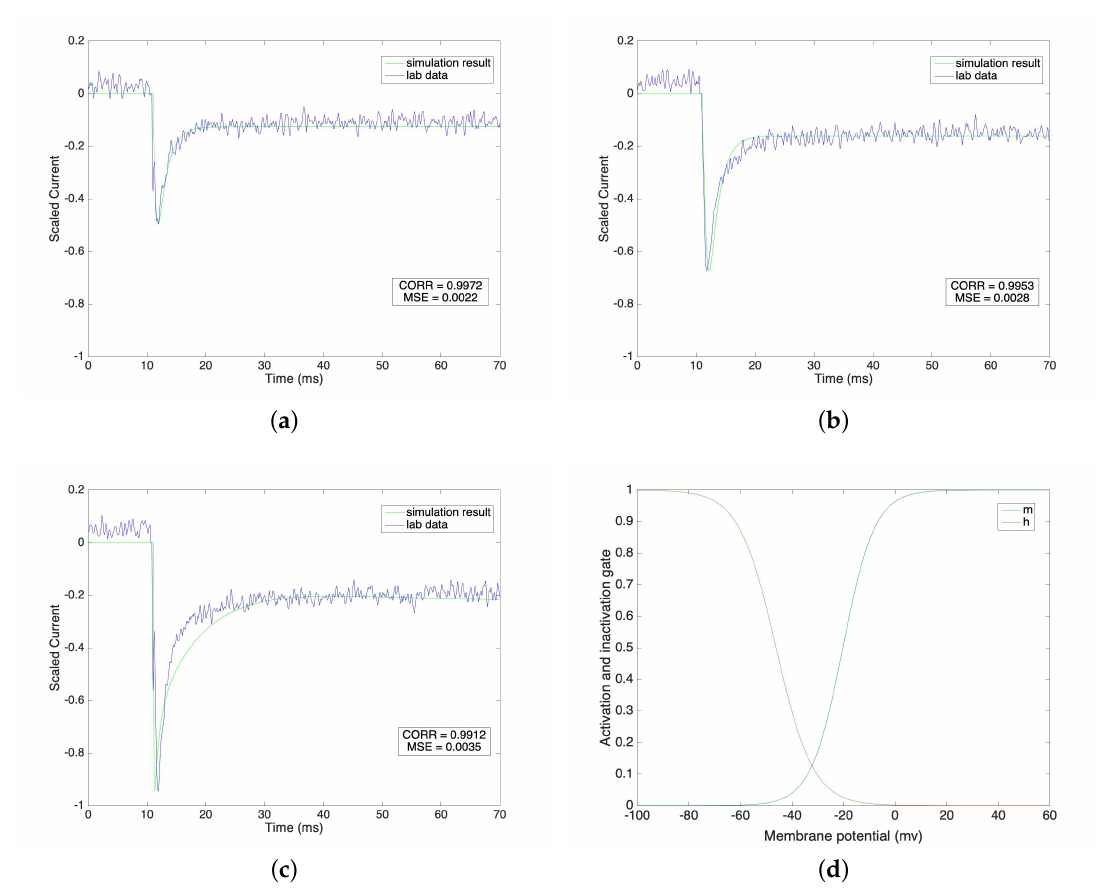
Figure 1. ( a – c ) Sodium current under different voltage clamp values( − 40 mV, − 20 mV and 0 mV). ( d ) Steady state of activation and inactivation gates dependent on membrane